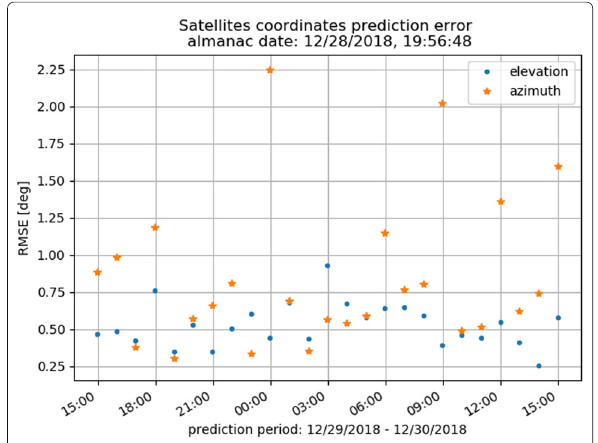
Fig. 8 Comparison between visible satellites coordinates computed with algorithm from Section 5.3.3, and those obtained from NMEA data provided by USB antenna